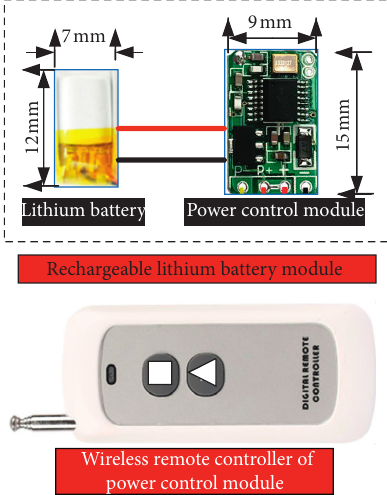
Figure 2: Battery module